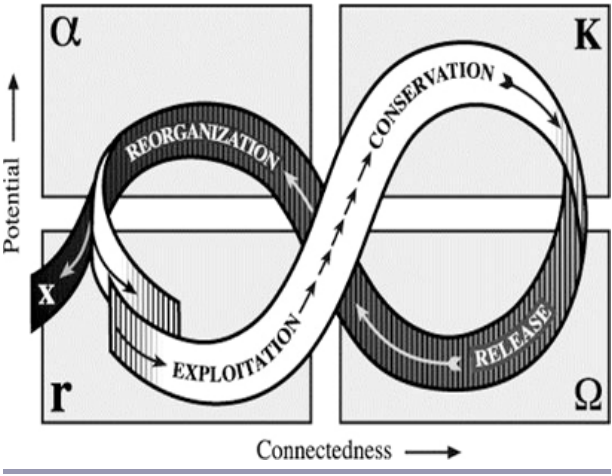
Fig. 1: The adaptive cycle throughout its four phases: exploitation, conservation, release, and reorganization. The phases vary in the level of connectedness (x-axis) and potential (y-axis). From Panarchy edited by Lance H. Gunderson and